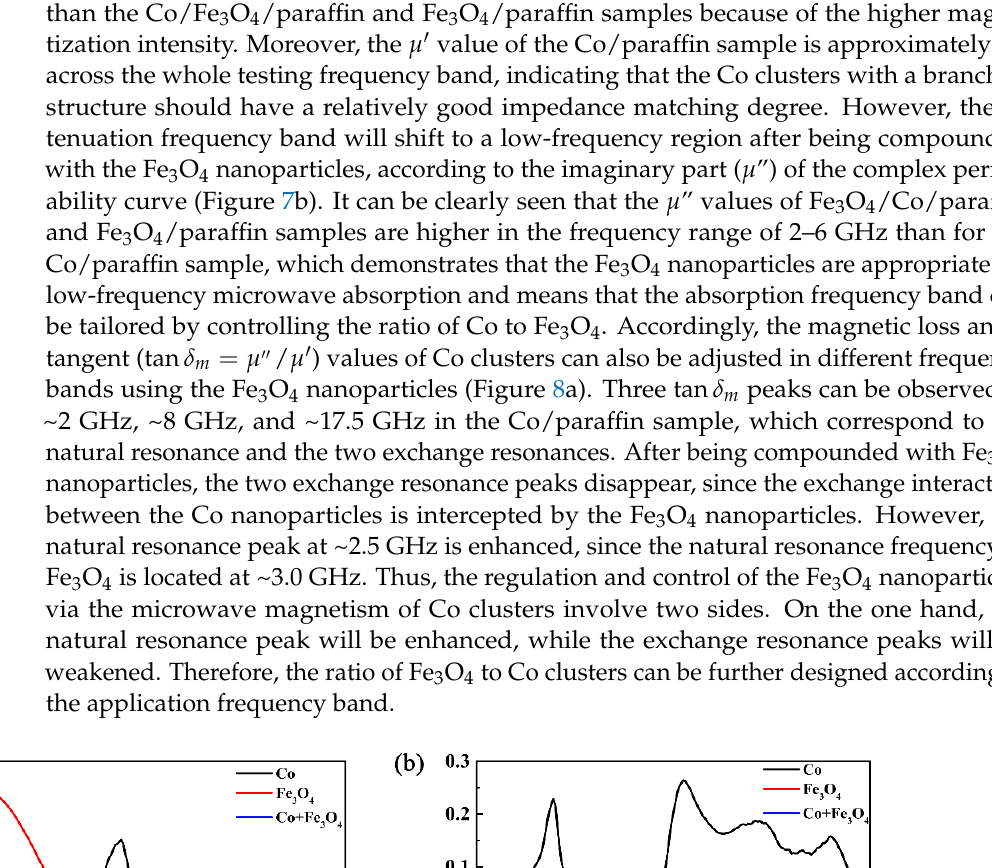
Figure 7. ( a ) Real ( μ ′ ) and ( b ) imaginary ( μ ″ ) parts of the Co, Fe 3 O 4 and Co/Fe 3 O 4 as functions of the frequency.